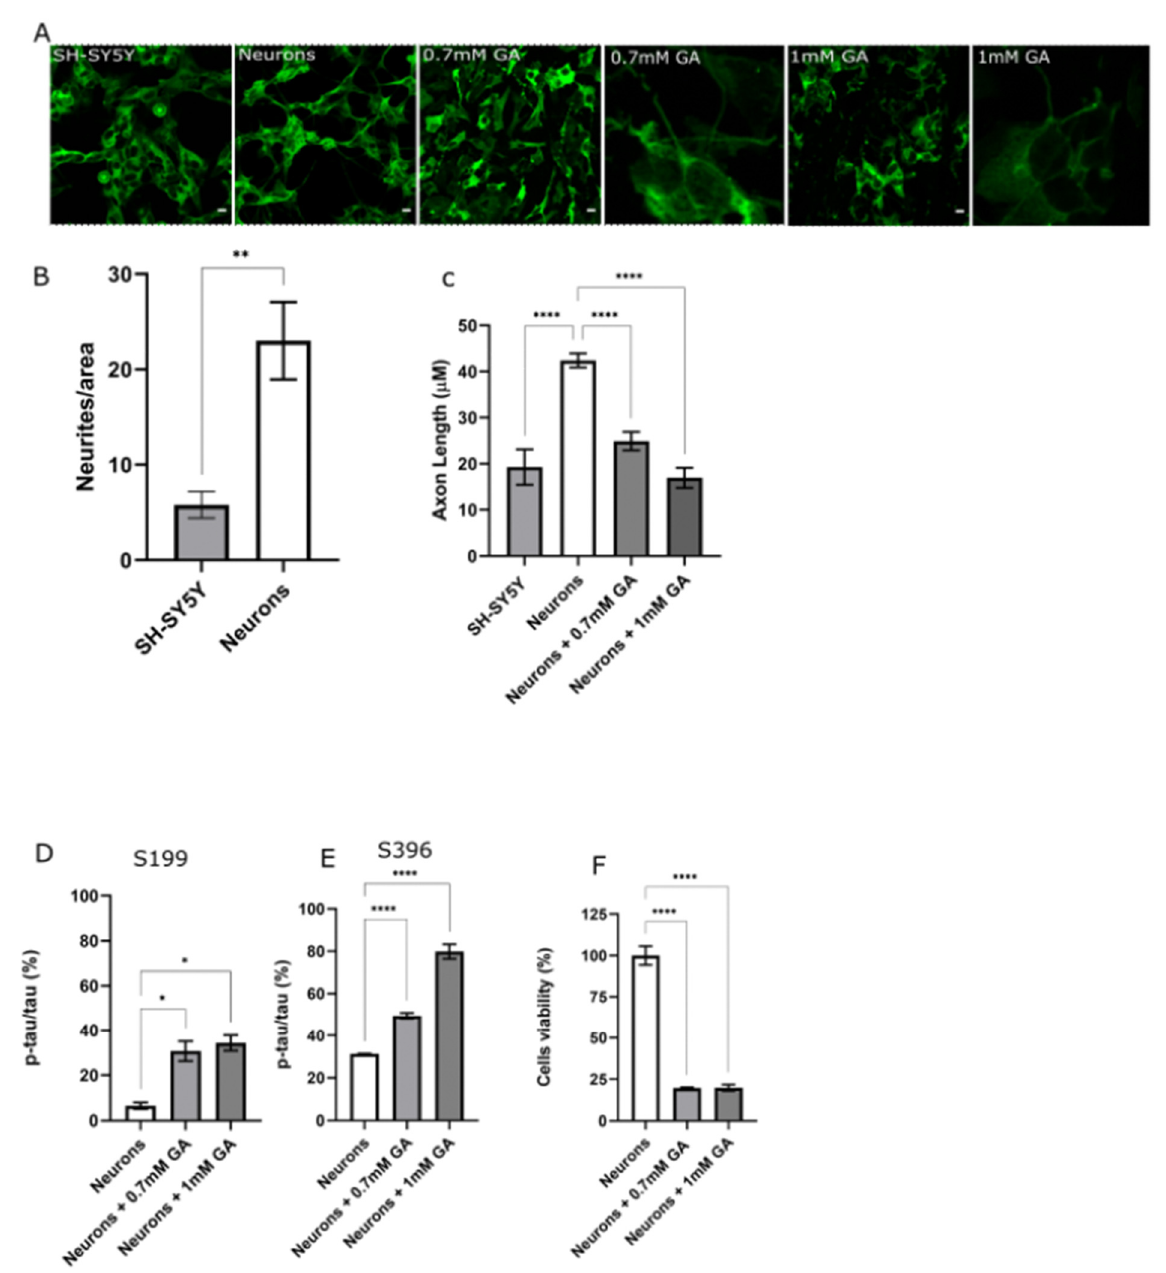
Figure 1. Characterization and validation of novel AD cell model ( A ) Confocal images of SH-SY5Y cells, SH-SY5Y-derived neurons, and SH-SY5Y neurons treated with 0.7 mM GA or 1 mM GA, and zoom-in on degenerating neurites. Scale bar 100 μ M. ( B ) Neurite density quantification of SH-SY5Y cells and SH-SY5Y-derived neurons. Mann–Whitney test was used to compare differences between different groups. ( C ) Neurite length quantification of SH-SY5Y cells, SH-SY5-derived neurons, and SH-SY5Y-derived neurons following GA treatment at different concentrations. Ordinary one-way ANOVA followed by Tukey’s post-hoc test was used to compare differences between different